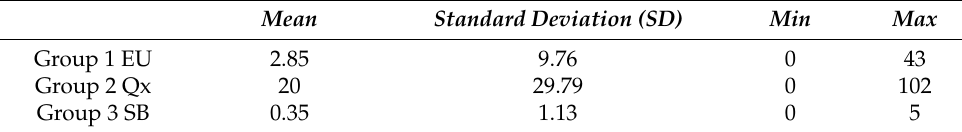
Table 1. Mean counts of Enteroccus faecalis CFUs 24 h post-treatment.